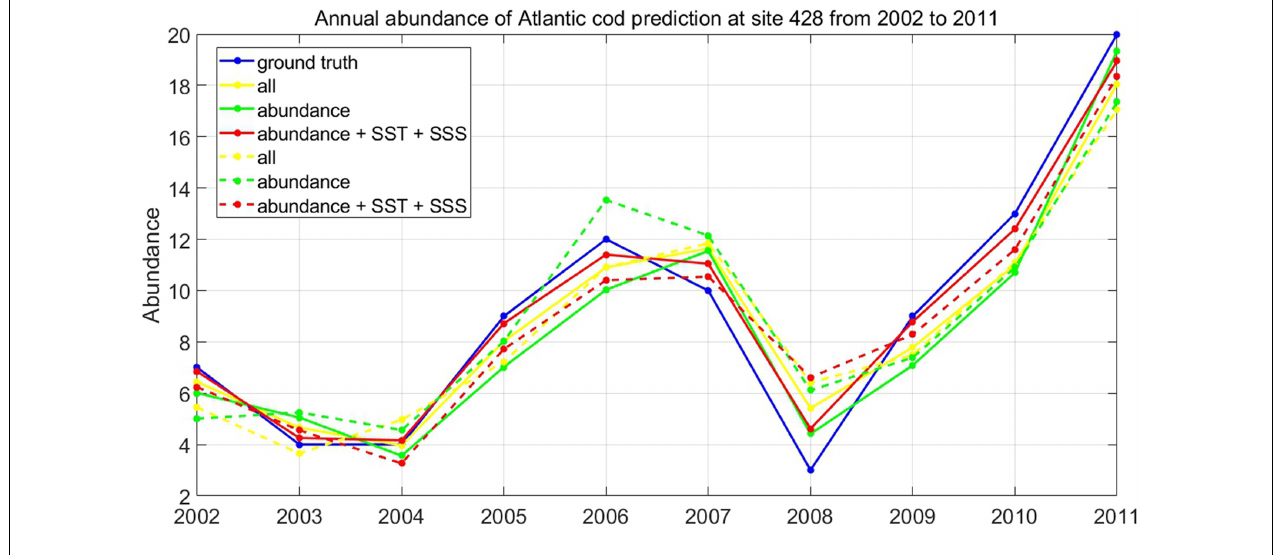
FIGURE 9 | Prediction of Atlantic cod